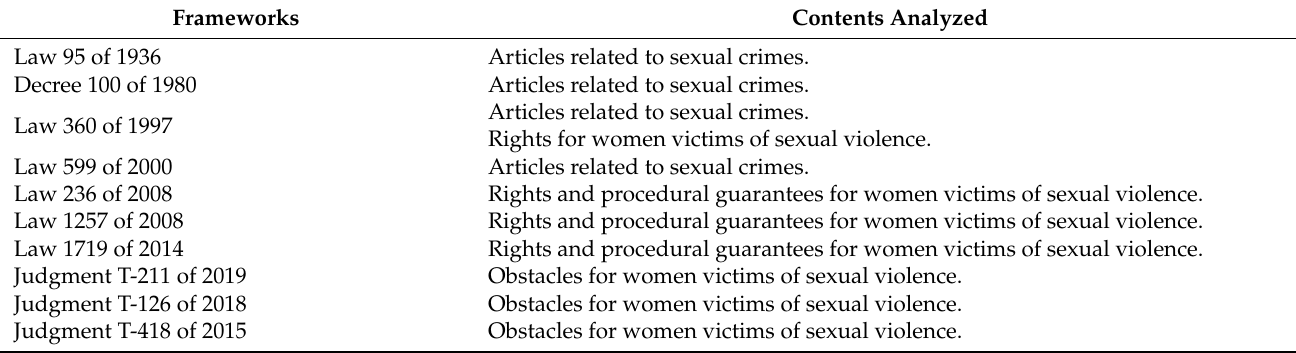
Table 1. List of legal frameworks and